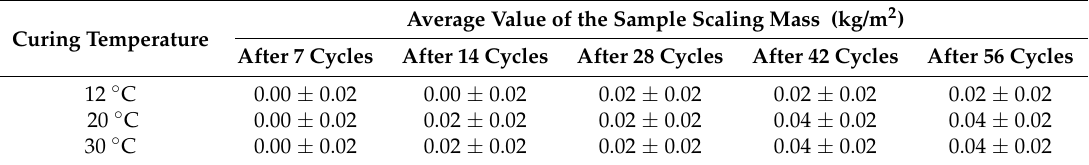
Table 9. Results of the tests of resisting of the concrete samples to cyclic freezing and thawing in the presence of de-icing salt (3% NaCl), cured at 12, 20, and 30 ◦